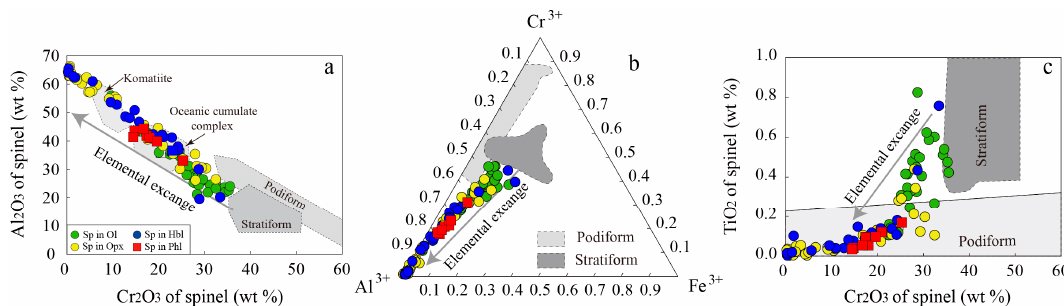
Figure 7. Chemical compositions of spinel, compared with spinel from different tectonic settings on ( a ) Cr 2 O 3 vs. Al 2 O 3 ( b ) Cr 2 O 3 vs. Al 2 O 3 vs. Fe 2 O 3 ( c ) TiO 2 vs. Cr 2 O 3 diagrams. The komatiite and oceanic cumulate complex fields are from Kamenetsky et al. [5]. Podiform and stratiform fields are from Musallam et al. [102] and Arai et al.